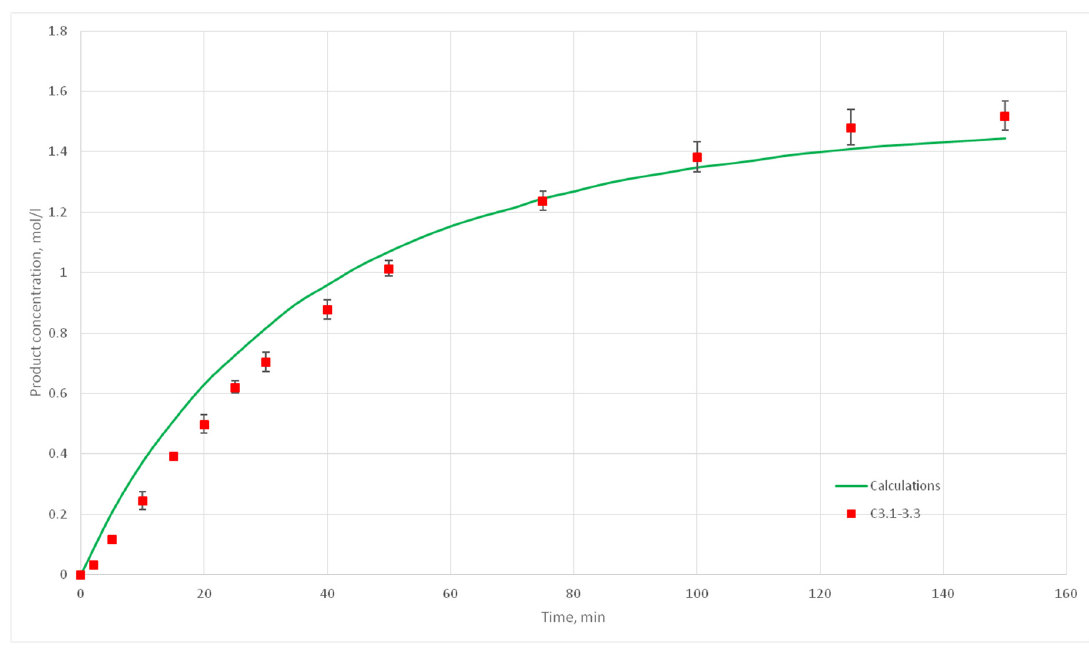
Figure 21. Calculation and experimental reaction kinetic curves for С 3.1, 3.2 и 3.3 experiments.